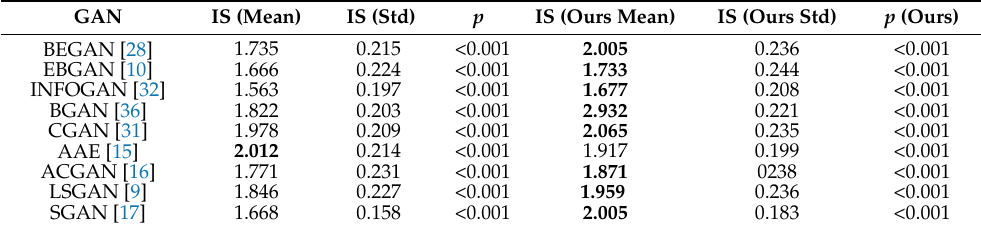
Table 2. Score (IS) test on GANs